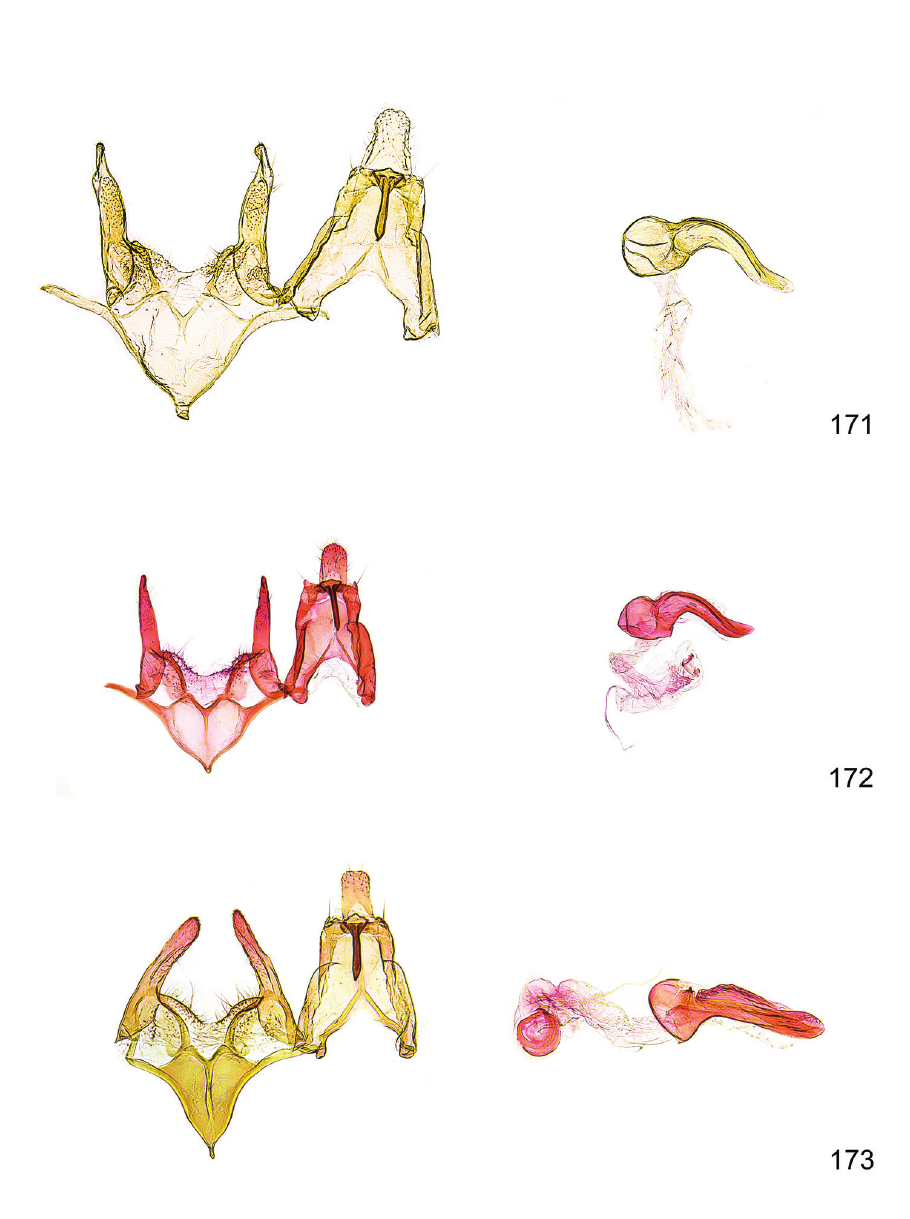
Figures 171–173. Megacraspedus male genitalia. 171 M. dolosellus (Zeller, 1839) – Lectotype ( incertel- lus ), Bulgaria, gen. slide 16.518 (NHMW) 172 M. dolosellus (Zeller, 1839) – Greece, GU 16/1441 P.H. (ZMUC) 173 M. neli sp. n. – Holotype, France, GEL 1218 P.H.